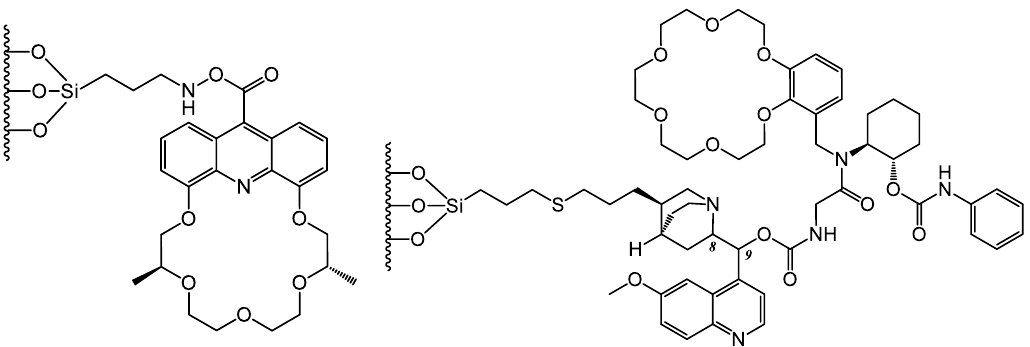
Figure 4. Structures of CSPs applied in Ref. [28] (left) and Ref. [29]